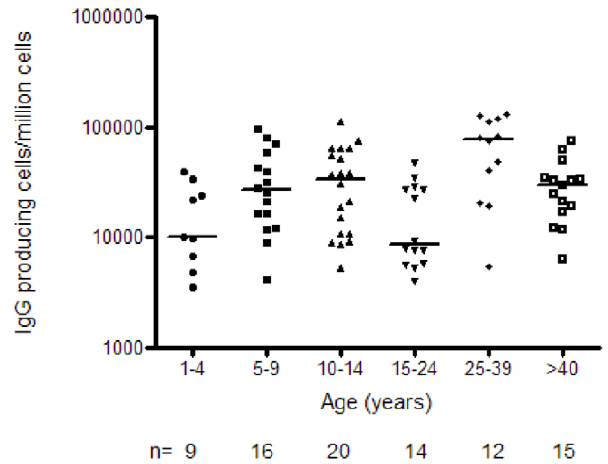
Figure 2. Accumulation of MBC with age. The total number of MBC/million PBMC (as measured by their conversion into IgG producing cells after culture) were counted for each individual using the B cell ELISpot technique, and are shown according to age group. The horizontal lines show the median values for each age group. N equals the number of tests that were performed per age group.